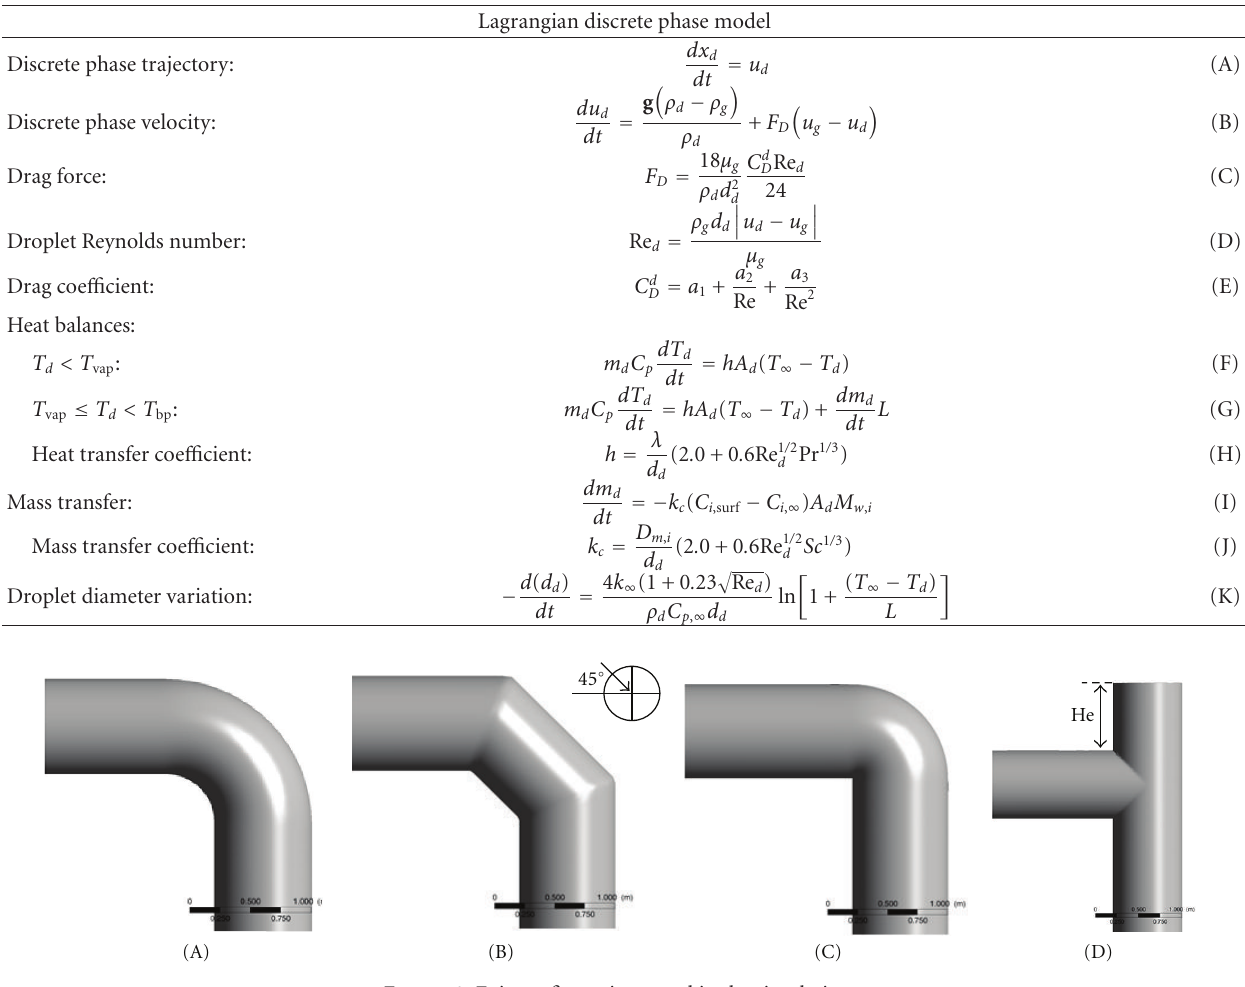
Table 4: Summary of Lagrangian equations.